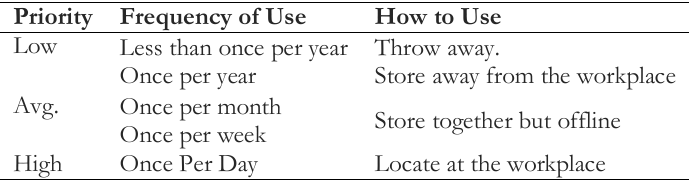
Table 2. Relationship between usage and frequency for listing